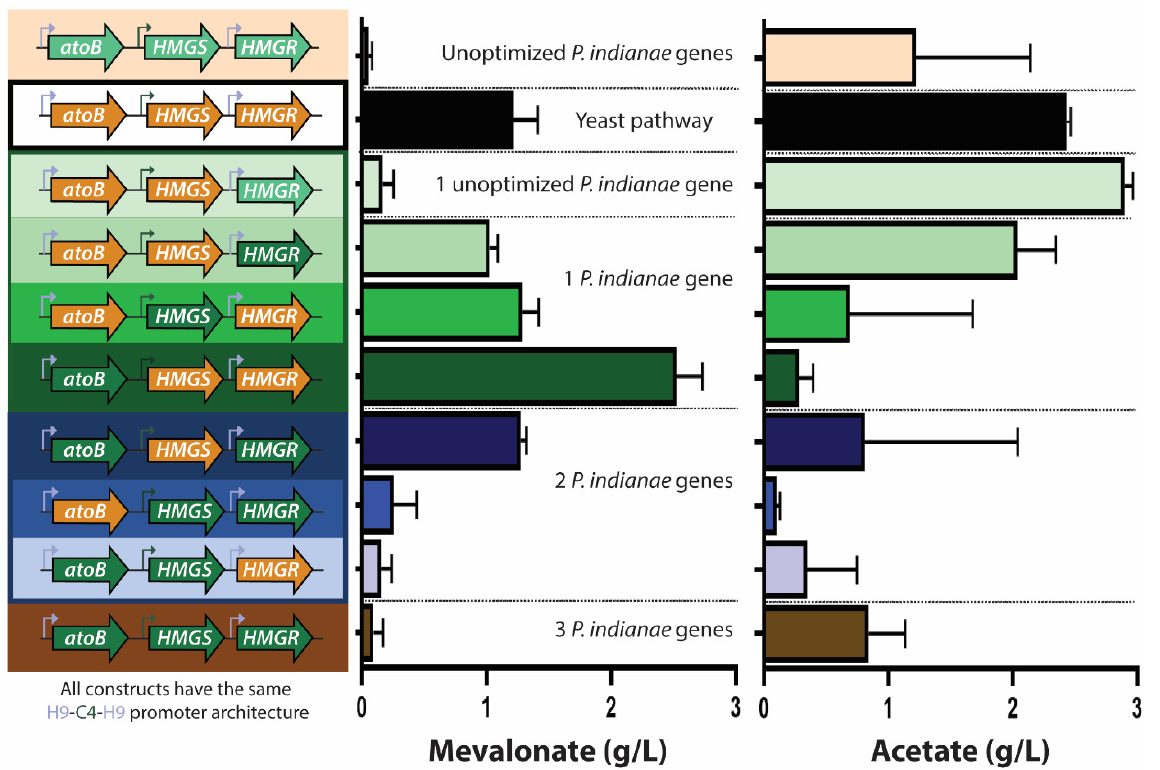
Figure 7. Mevalonate and acetate titers of original and hybrid mevalonate pathways. Pathway configuration ( left ), mevalonate production ( middle ), and acetate accumulation ( right ) from various mevalonate pathway hybrids containing individual genes from Martin et al. (orange), native P. indianae genes (light green), or E. coli -codon optimized P. indianae genes (dark green) after 20 h of culture. Green bars represent pathways with one PI homolog, blue bars and brown bars represent pathways with two and three PI homologs, respectively. All pathways are configured in the high-producing h9-promoter configuration. Errors bars represent standard deviation; n = 3 for all